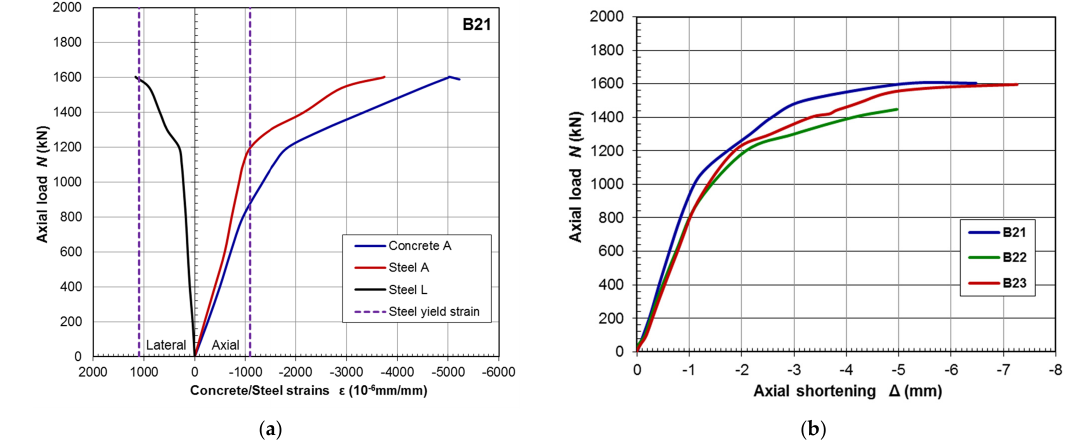
Figure 8. Measured axial load versus strains ( a ) and load versus deformation ( b ) relationships of the first group of strengthened specimens (B2x series).